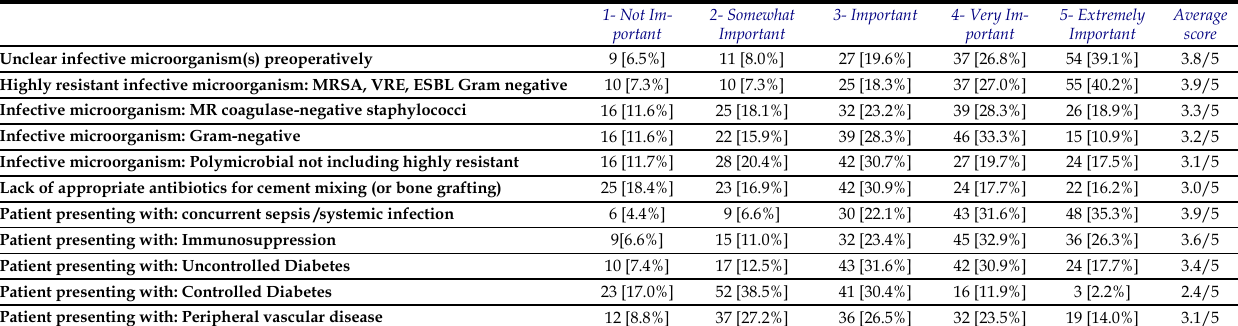
Table 4B. Delegates voting on importance of several factors in choosing Two-stage and NOT One-stage procedures.